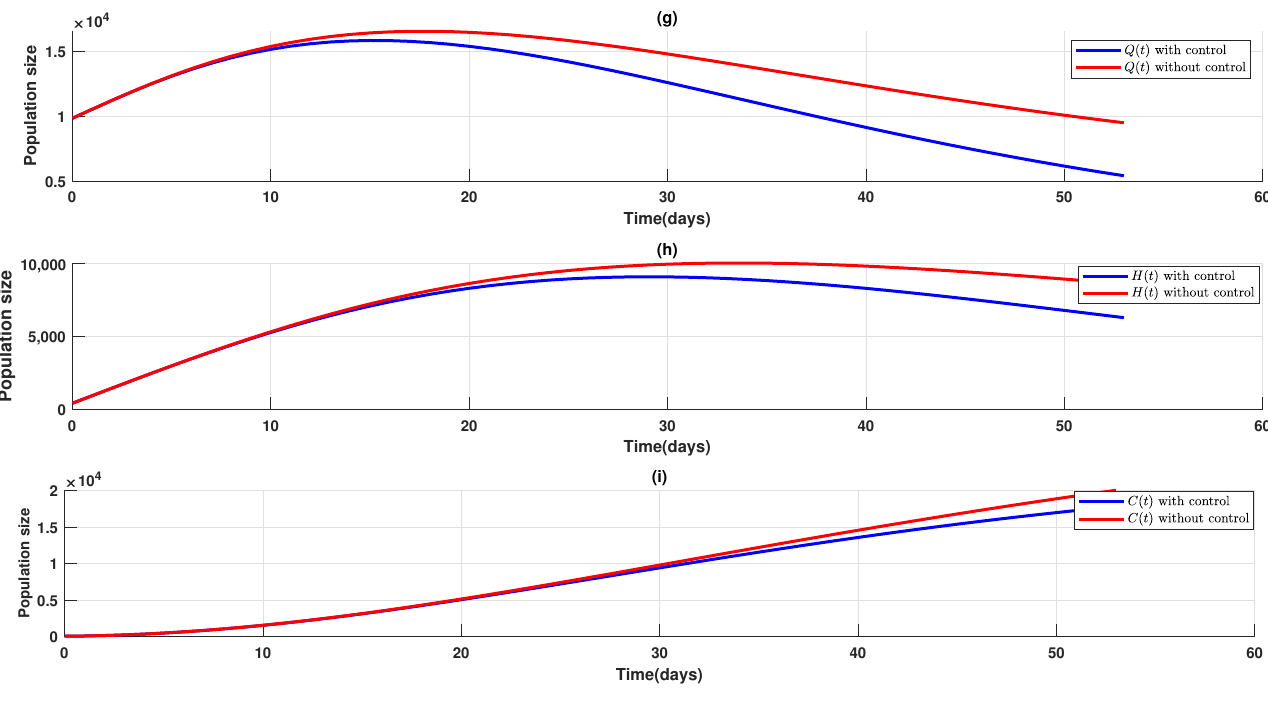
Figure 6. Time series of the states Q, H and C with and without control.